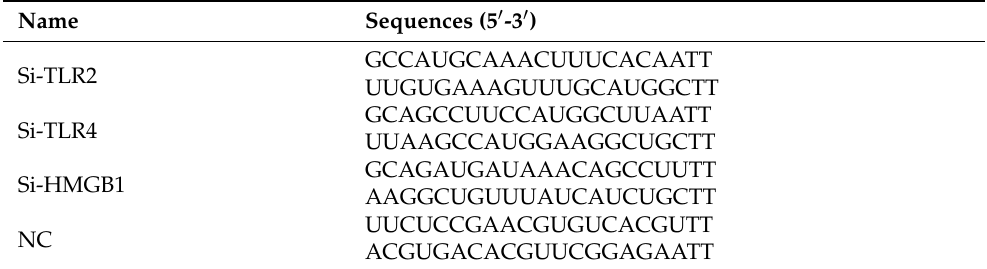
Table 2. Sequences of RNA